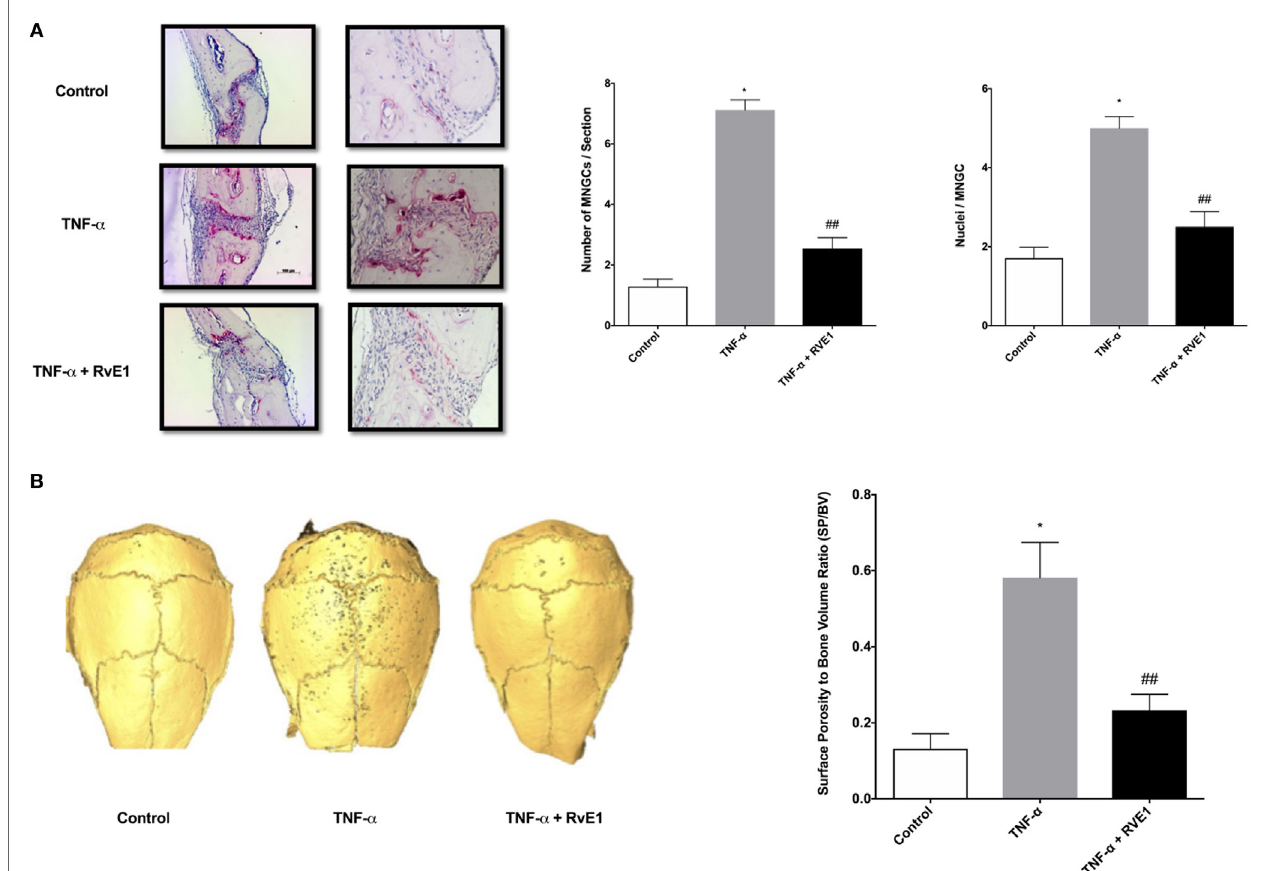
FigUre 1 | (a) RvE1 reduces osteoclastogenesis triggered by TNF- α injections. TRAP-positive multinucleated giant cells (MNGCs) were counted in each section and the mean number of nuclei/cell/section was calculated by dividing the number of nuclei by the number of MNGCs found in each section. Statistically significant increases in numbers of MNGCs and nuclei/MNGC/section were measured in sections from samples receiving supracalvarial TNF- α injections when compared to samples receiving PBS injections ( p < 0.05). Statistically significant decrease in both values was found in samples from animals treated with daily injections of RvE1 when compared to the TNF- α only group ( p < 0.05). (B) Protective role of resolvin E1 (RvE1) in murine calvariae. Significant increases in the surface porosity (SP)/bone volume (BV) ratio was noted in specimens from the tumor necrosis factor- α (TNF- α ) group when compared to the negative control and RvE1 treatment group ( n = 3, p < 0.05). Reconstruction was performed using Amira 3D software. BV and SP measurements were calculated using the same software. SP/BV measurements were calculated to standardize the surface area being examined for porosity. Results are expression of the mean SP/BV ratio. * p < 0.05 vs. control. ## p < 0.05 vs. active control.